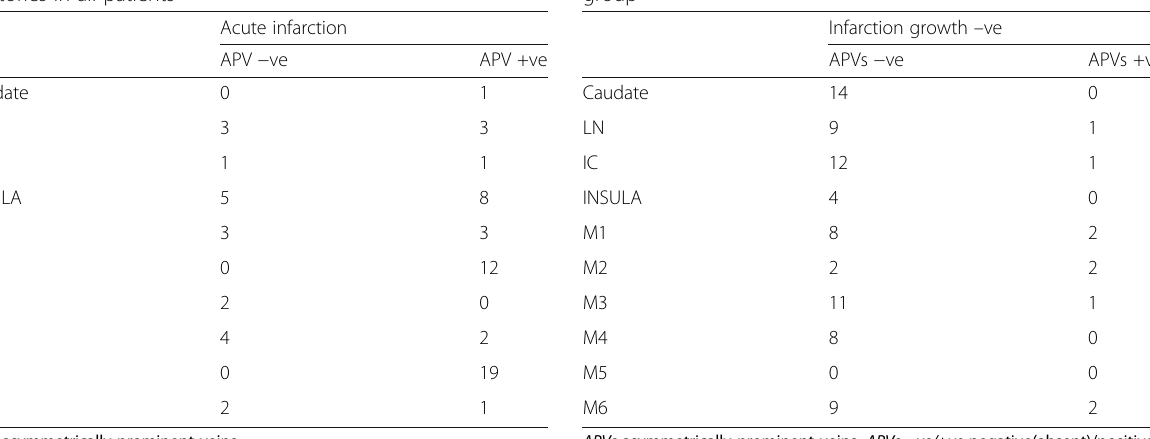
Table 5 Distribution of APVs in the MCA territories in NIG group